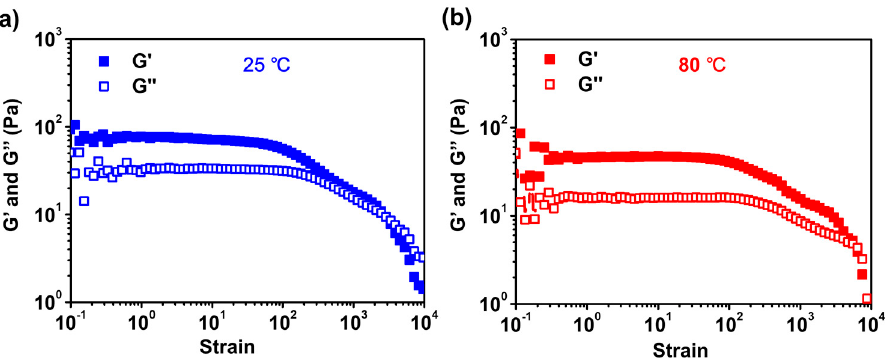
Figure 8. Comparison of the temperature stability of HPs doped hydrogel under varying shear